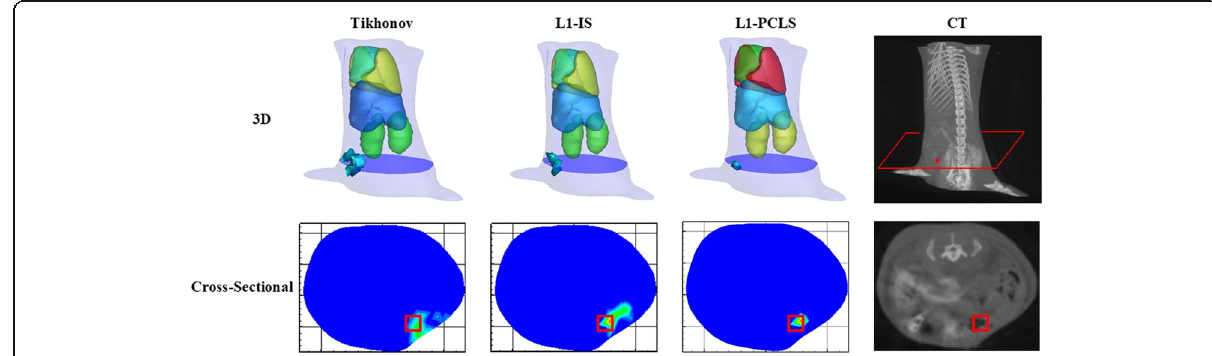
Fig. 2 Views of the reconstruction results using L 2 -norm regularization (Tikhonov), L 1 -norm regularization (L1-Iteration Shrinkage, L1-IS) and L 1 - norm regularization piecewise constant Level-Set (L1-PCLS) methods. The blue plane in the figure is the z = 6.4 mm slice from the mice. The red dot marks the real position of the fluorescent bead. The figure is reproduced from [98]